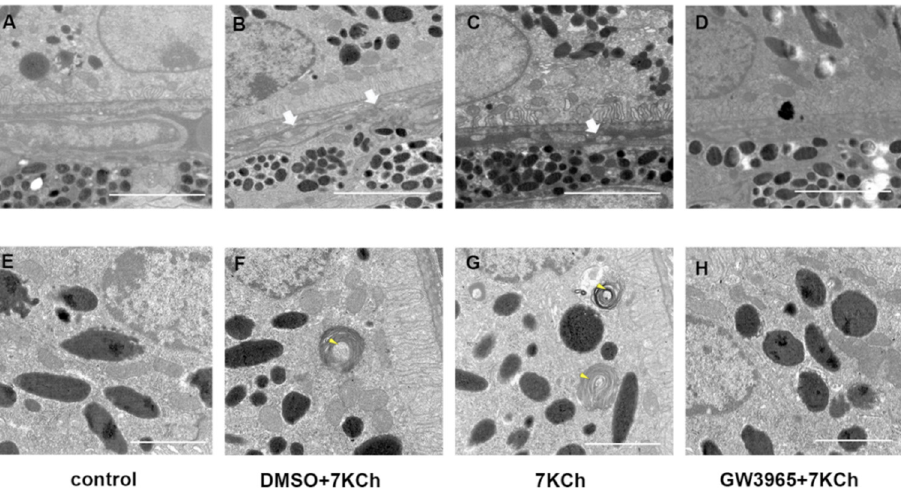
Figure 4. TEM examination of the retinas. ( A , E ) C57BL/6 mice were gavaged saline (100 μ L/10 g) for seven days. ( B , F ) First, C57BL/6 mice were gavaged DMSO (1%) for three days, and then they were subretinally injected 7KCh. After injection, gavaging with DMSO (1%) continued for four days. ( C , G ) C57BL/6 mice were gavaged saline (100 μ L/10 g) for three days, then they were subretinally injected 7KCh. After injection, gavaging with saline (100 μ L/10 g) continued for four days. ( D , H ) C57BL/6 mice were gavaged GW3965 (10 mg/kg) for three days, and then they were subretinally injected 7KCh. After injection, gavaging with GW3965 (10 mg/kg) continued for four days ( n = 3). White arrows indicate electron-dense material above the BrM. Yellow arrows indicate undigested POS. ( A – D ), scale bar 2 μ m. ( E , F ), scale bar 1 μ m.